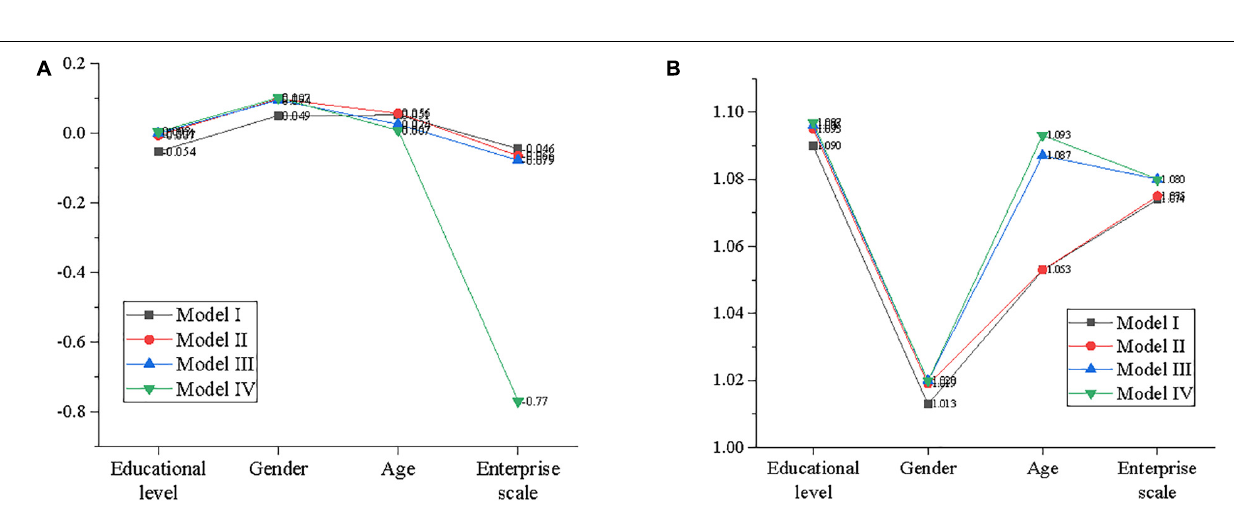
Frontiers in Psychology |